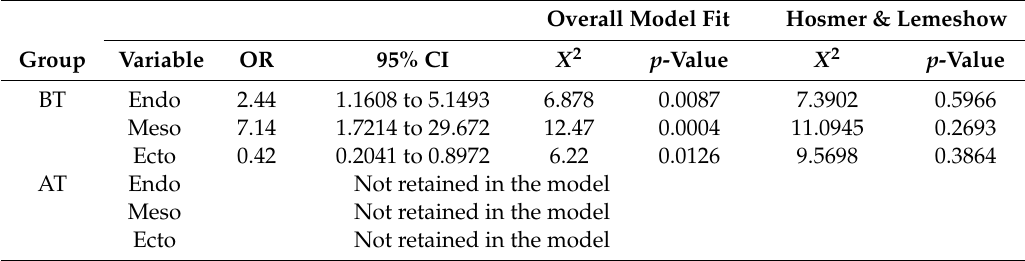
Table 6. Associations between somatotype components and eating disorders. Overall Model Fit Hosmer &